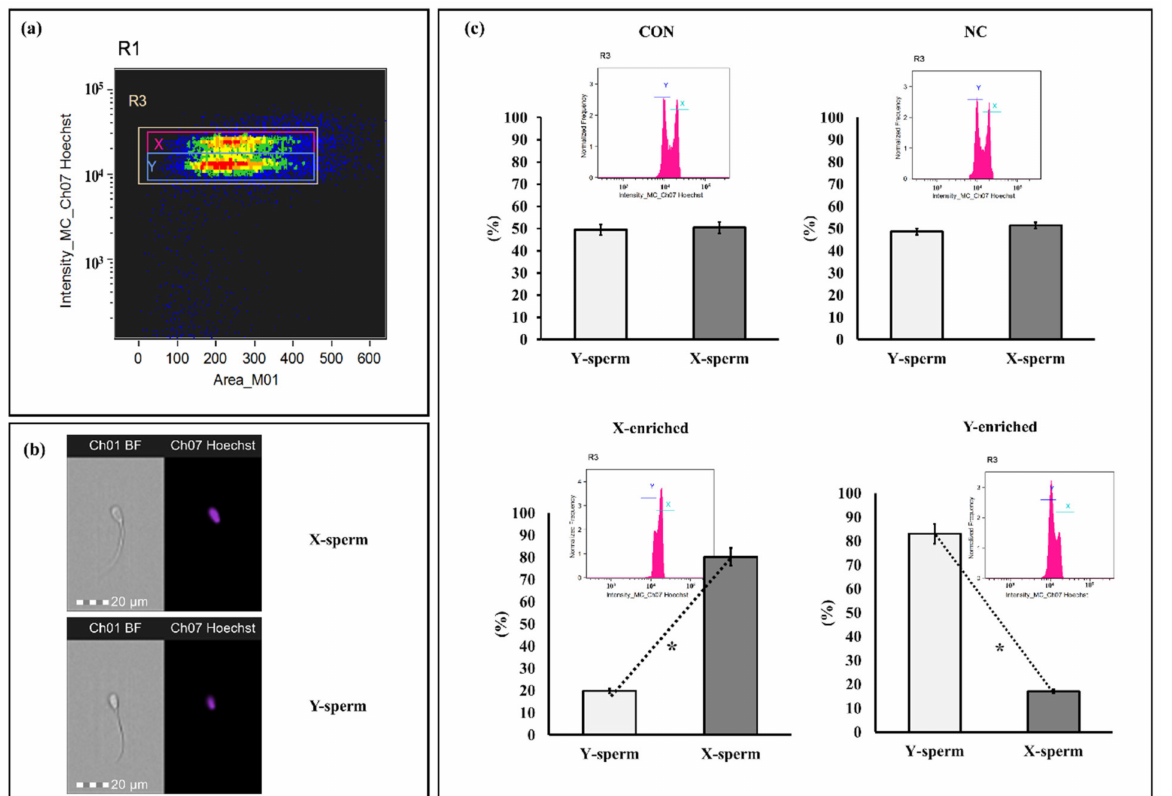
Figure 6. Discrimination between X- and Y-sperm after sexing by PY magnetic beads. ( a ) Regions are utilized to analyze sperm bearing the X and Y chromosomes. Separate populations of sperm bearing X and Y chromosomes were isolated, and the sex ratio in each sample was evaluated. ( b ) Patterns of sperm were observed with Hoechst 33,342. ( c ) Frequency histogram and percentage of sperm after staining with Hoechst 33,342. Con: conventional frozen–thawed semen; NC: conventional semen incubated with inactive magnetic PLA-M; X-enriched: fraction of sperm not bound by PY-magnetic beads; Y-enriched: fraction of sperm entrapped by PY-magnetic beads. * Paired t -tests were used to compare X- and Y-sperm from each group. p -value < 0.05 is statistically